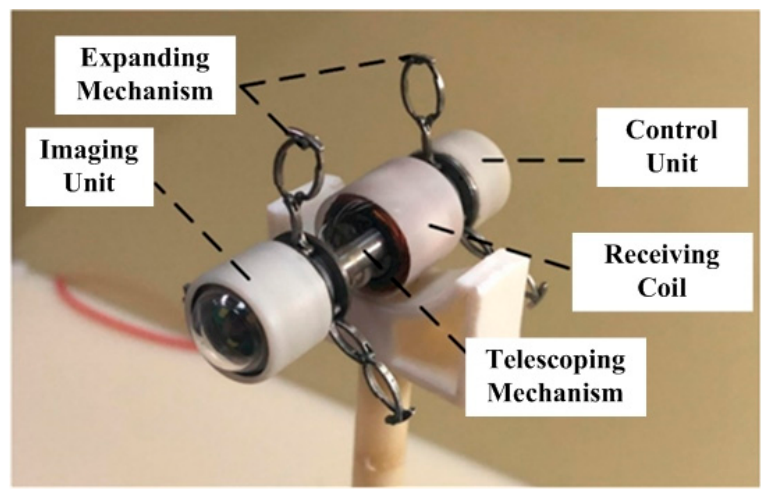
Figure 11. Prototype of the inchworm-like intestinal micro-robot.